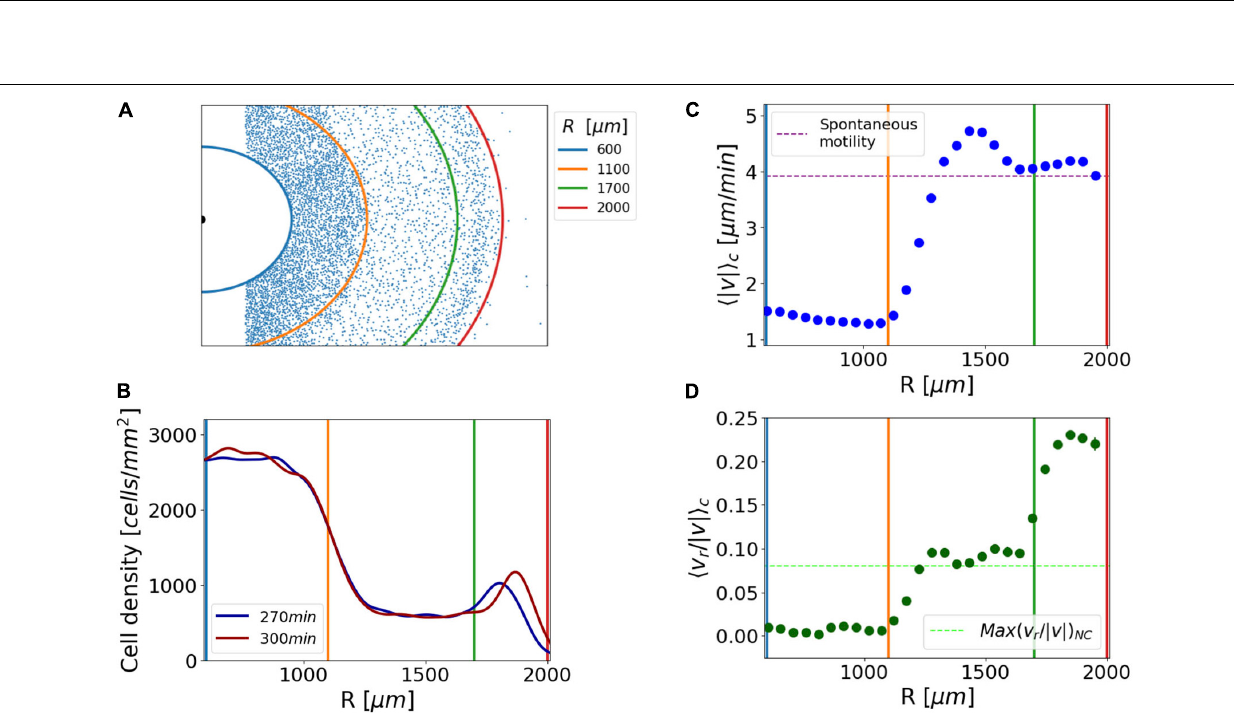
Frontiers in Cell and Developmental Biology |